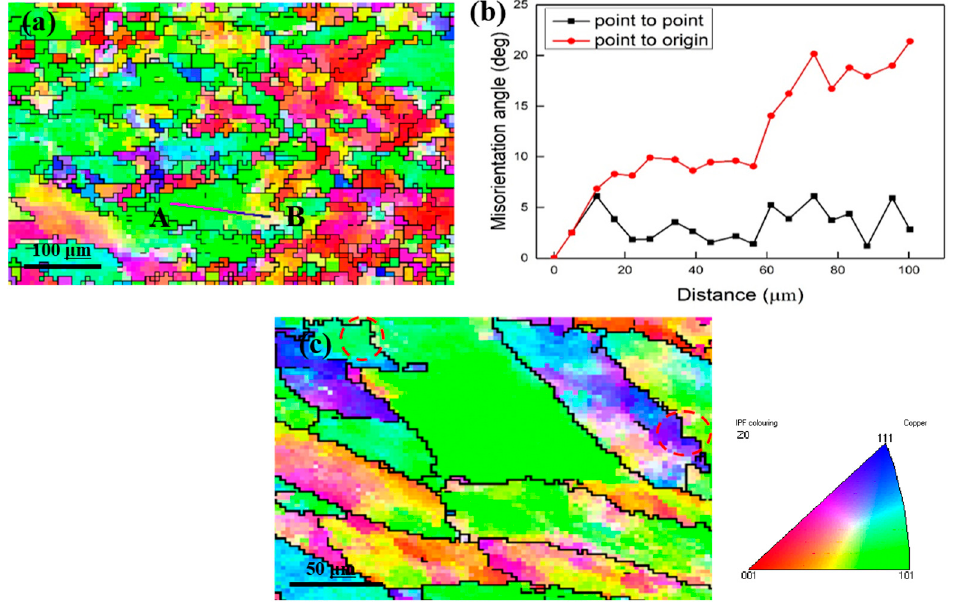
Figure 10. CDRX and DDRX mechanisms of the new type of Cu-1.1–Ni-0.7–Co-0.45–Si-0.3Cr alloy: ( a ) EBSD map, ( b ) Misorientation distribution along the line A–B in ( a ), ( c ) Grain boundary bulging.